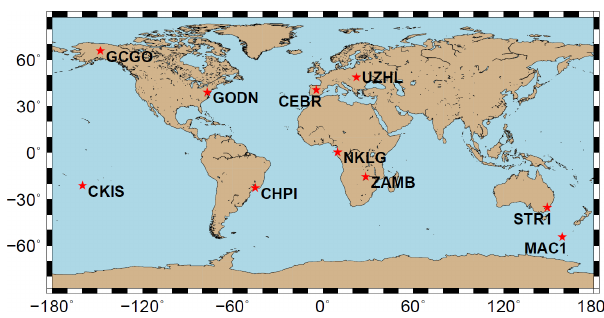
Figure 10. Distribution of the 10 IGS receiver stations used for the dSTEC analysis.